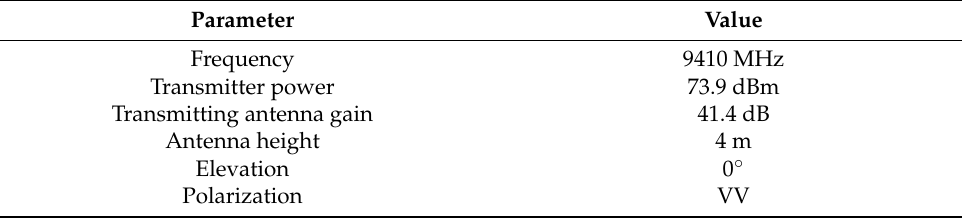
Figure 3. Sea clutter power for different EDHs: ( a ) EDHs range from 2 m to 20 m; ( b ) EDHs range from 22 m to 40 m. Table 1. Radar system parameters.